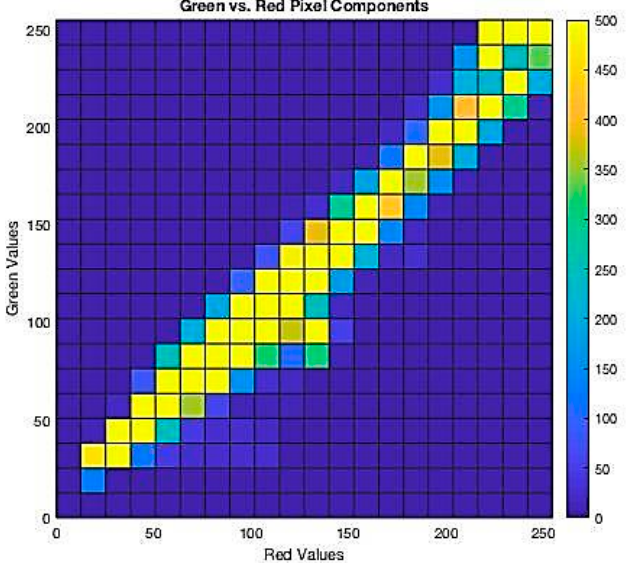
Figure 6. Green vs. red pixel components bivariate histogram that illustrates the colour frequencies and intensity.